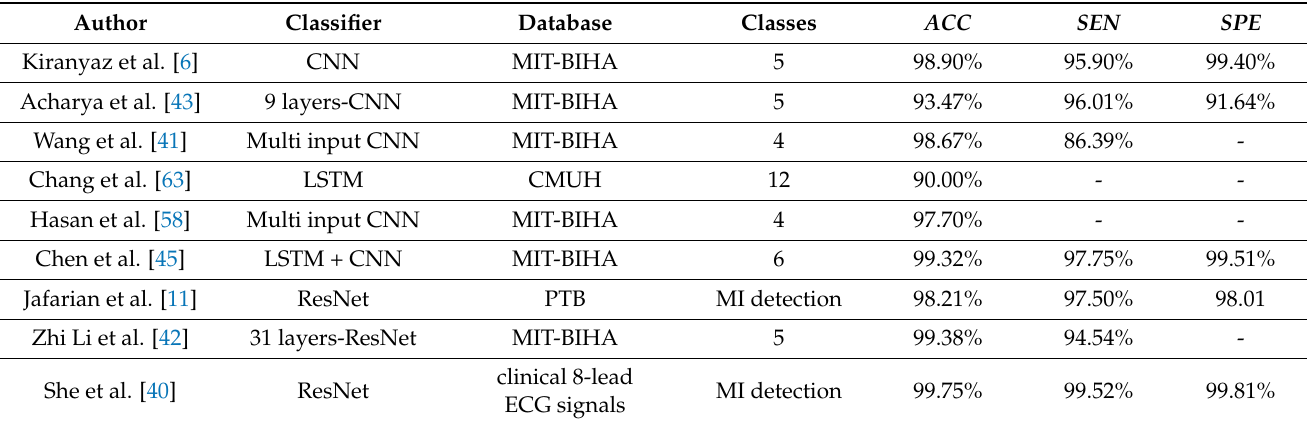
Table 3. Performance of different ECG diagnosis